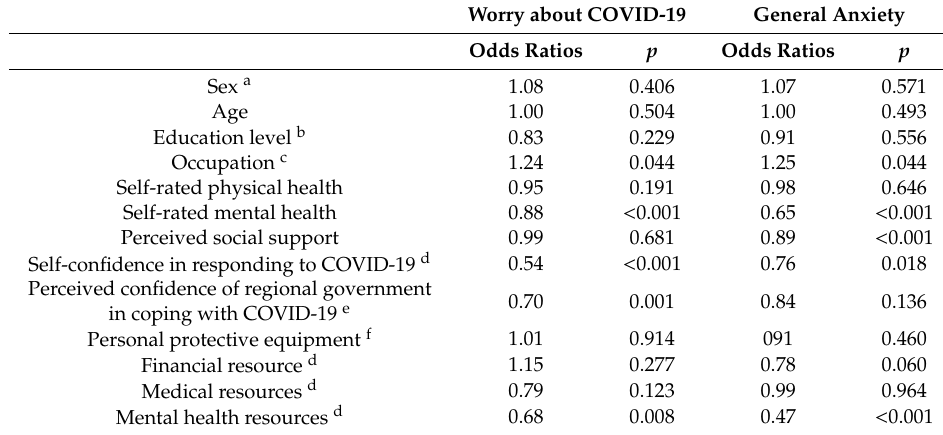
Odds ratios related to high worry toward COVID-19 and general anxiety during COVID-19